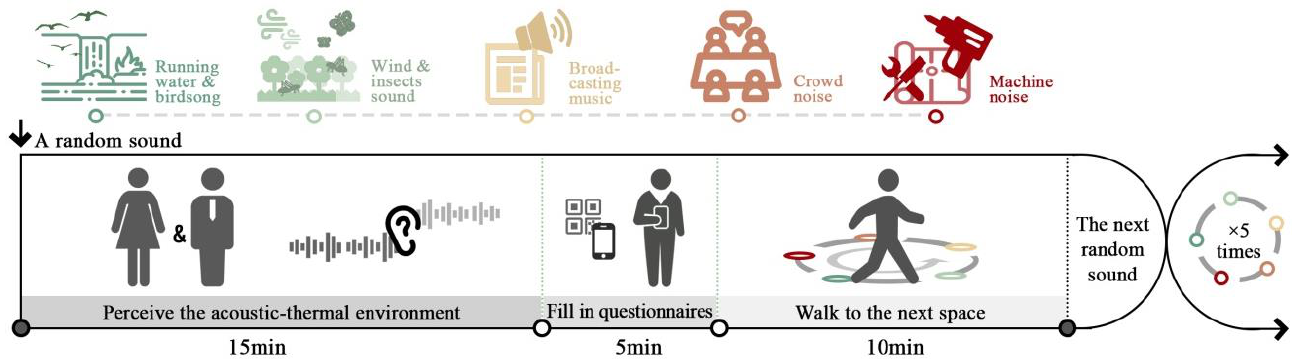
Figure 1. Experimental